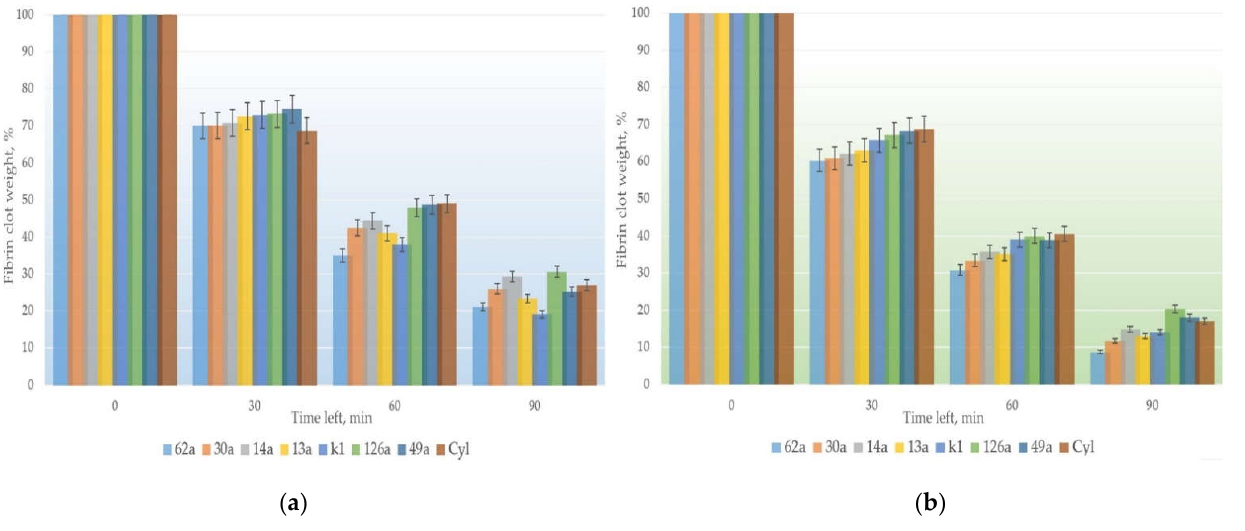
Figure 4. Determination of thrombolysis effectiveness of micromycete preparations in a fermentation medium with ( a ) starch and ( b ) glycerol.